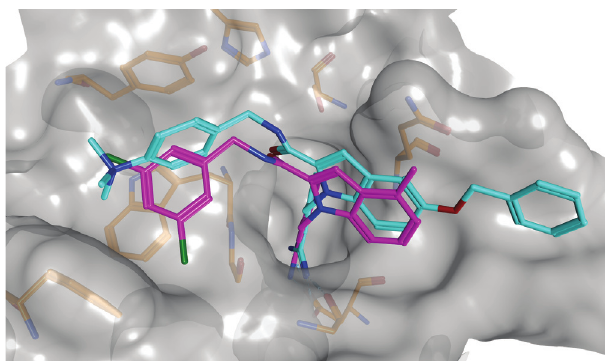
Figure 2. Binding mode prediction. In many instances, computer algorithms can predict correct or nearly correct interactions of small molecules and their target proteins. Shown are the X-ray structure of factor Xa (a serine protease) in complex with an inhibitor (cyan) and the putative binding mode of another inhibitor (magenta) generated by flexible ligand docking. The protein surface is rendered transpar- ent (gray) and selected active site residues are depicted. The factor Xa inhibitors and X-ray structure were reported in